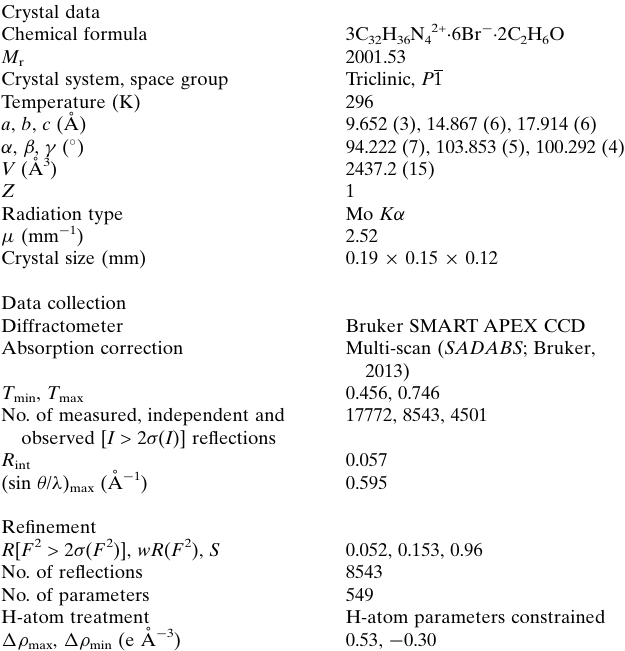
Table 2 Experimental details.